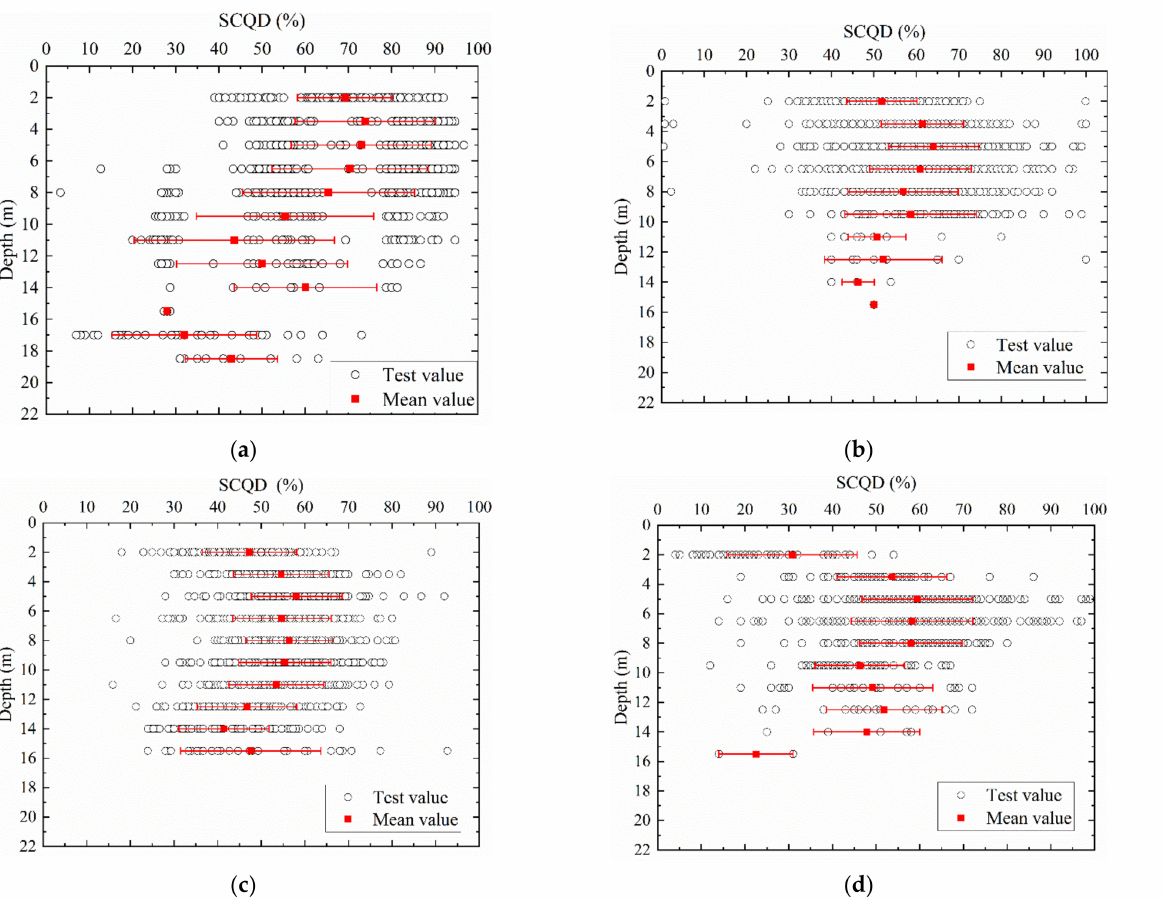
Figure 5. Relationship between SCQD and depth: ( a ) littoral soft soil; ( b ) lagoon soft soil; ( c ) alluvial soft soil (Ancient Yellow River); ( d ) alluvial soft soil (Yangtze